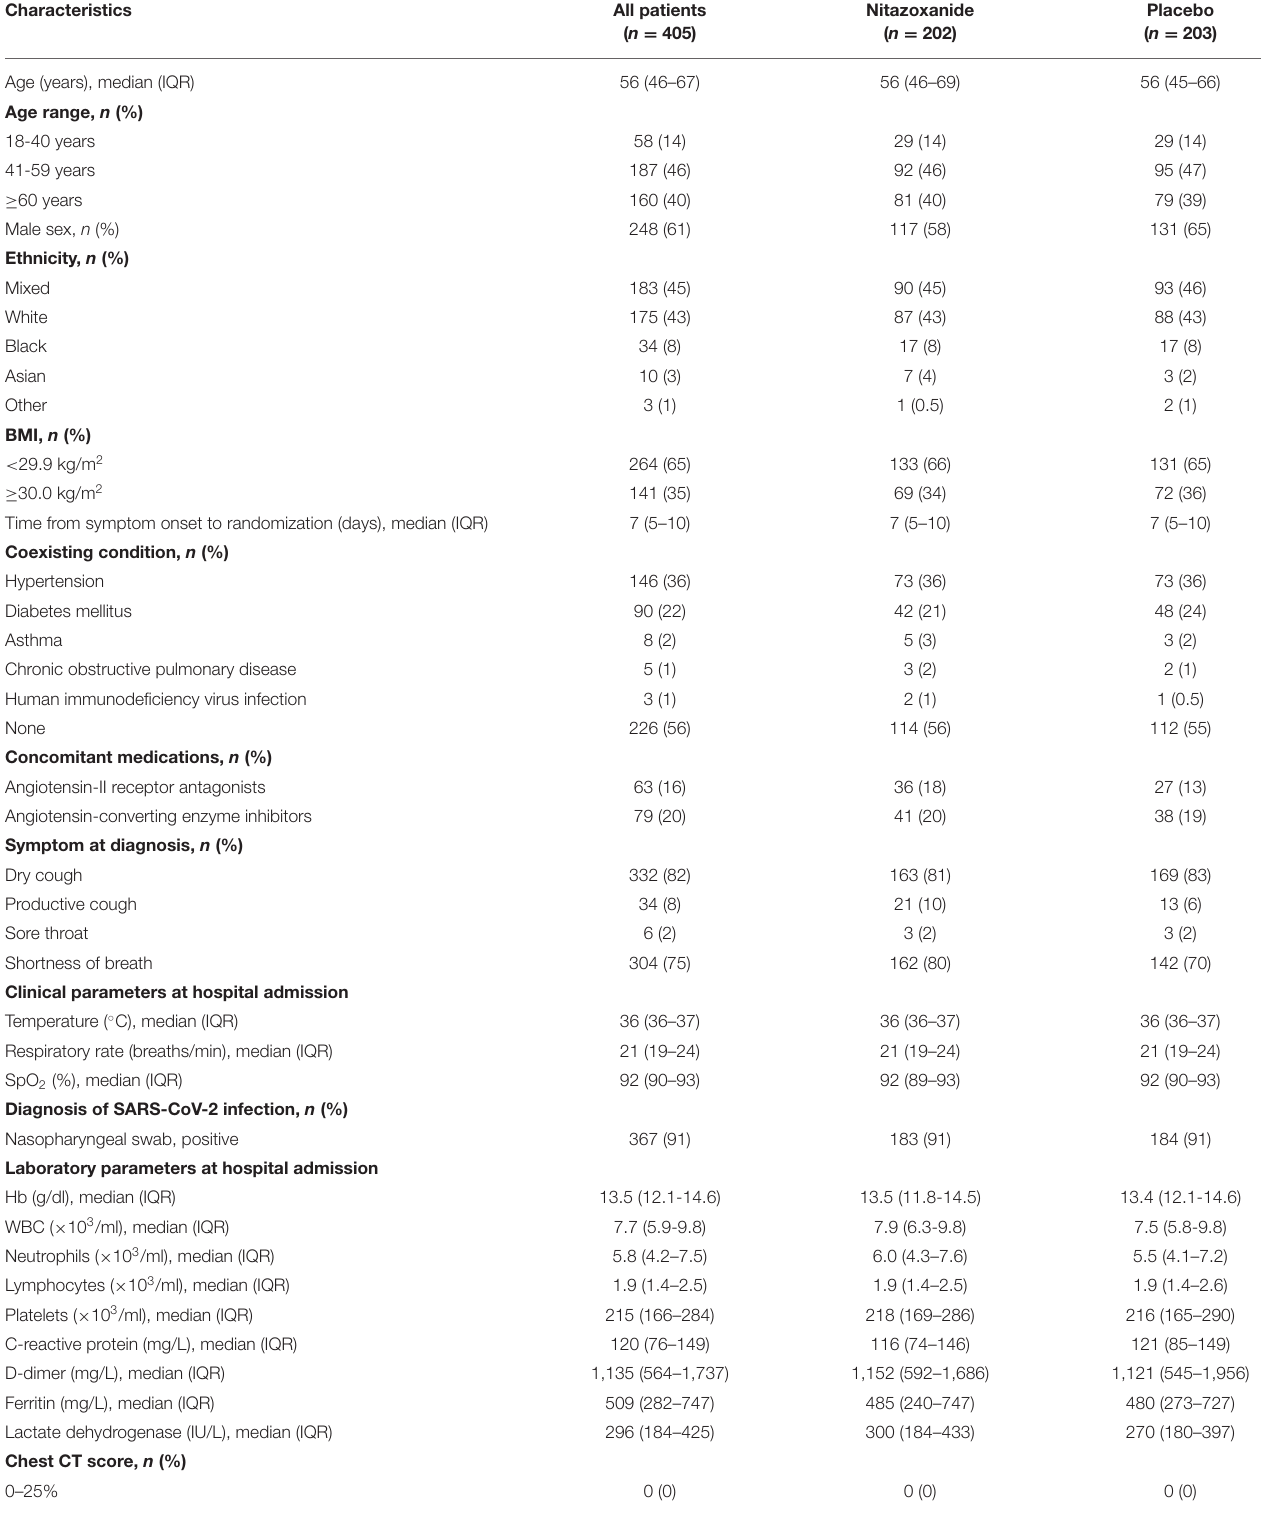
TABLE 1 | Demographic and disease characteristics of the patients at baseline in the mITT population. Characteristics All patients